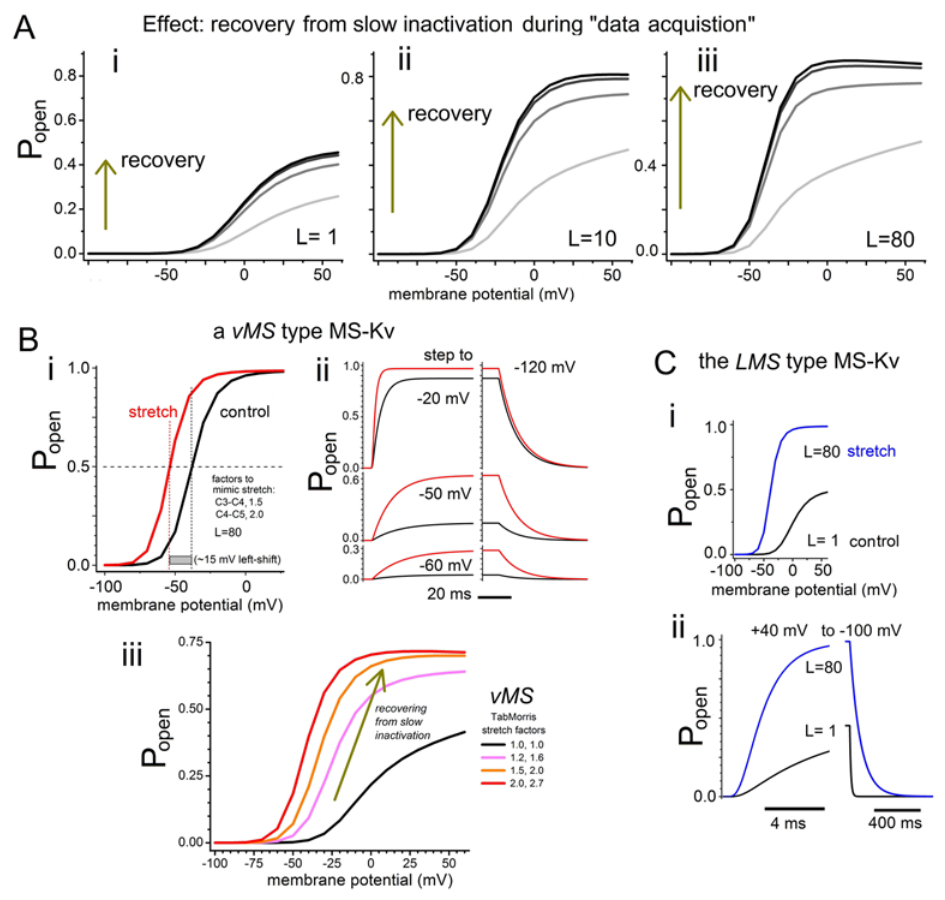
Fig 4. Mimicking excised patch datasets by adding slow inactivation and progressive vMS -type g(V) left-shifts to Scheme 1 . A, B , and C are explained in the text and by figure labels. For A and Biii , the systems are initiated (i.e., t = 0, Fig. 1D protocol) from the slow inactivated state. Note ( Bi versus C ) that the vMS and LMS models make qualitatively different predictions for the effect of “ membrane stretch ” on tail time courses (i.e., closing